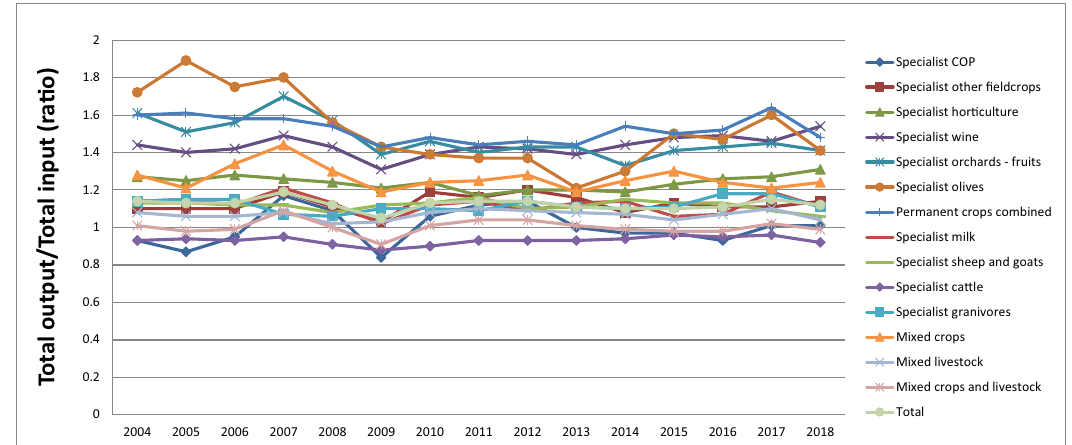
Figure 5: Total output/total input, per farm, for the several farm types, for the period 2004 – 2018.